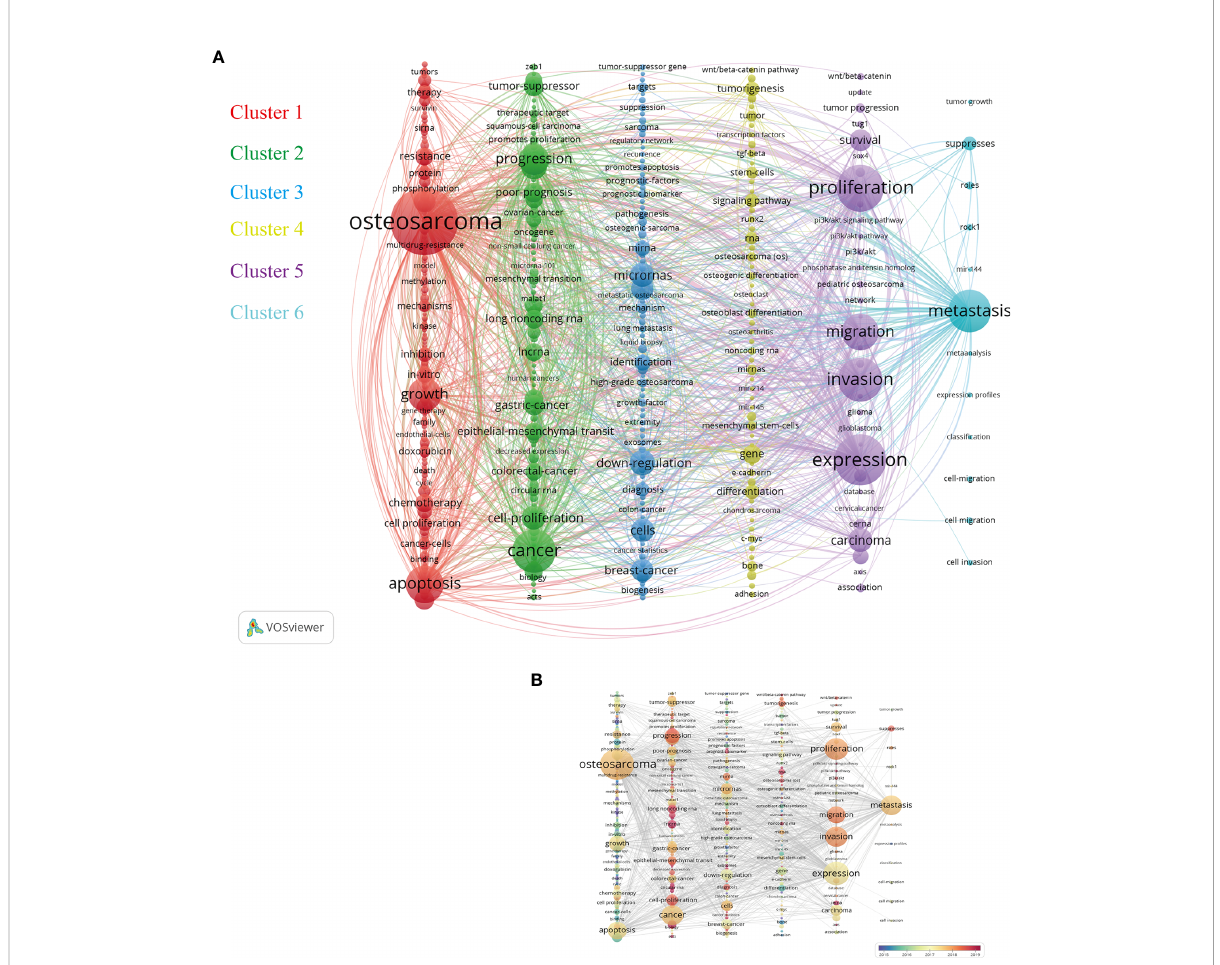
FIGURE 8 (A) Network visualization map of the keyword co-occurrence analysis by VOSviewer. Keywords with close relationship will be assigned to one cluster with the same color. The graphical explanations are the same as in Figure 4D. (B) Overlay visualization map of keyword analysis in this fi eld. The color of each node shows the average appearing year of the